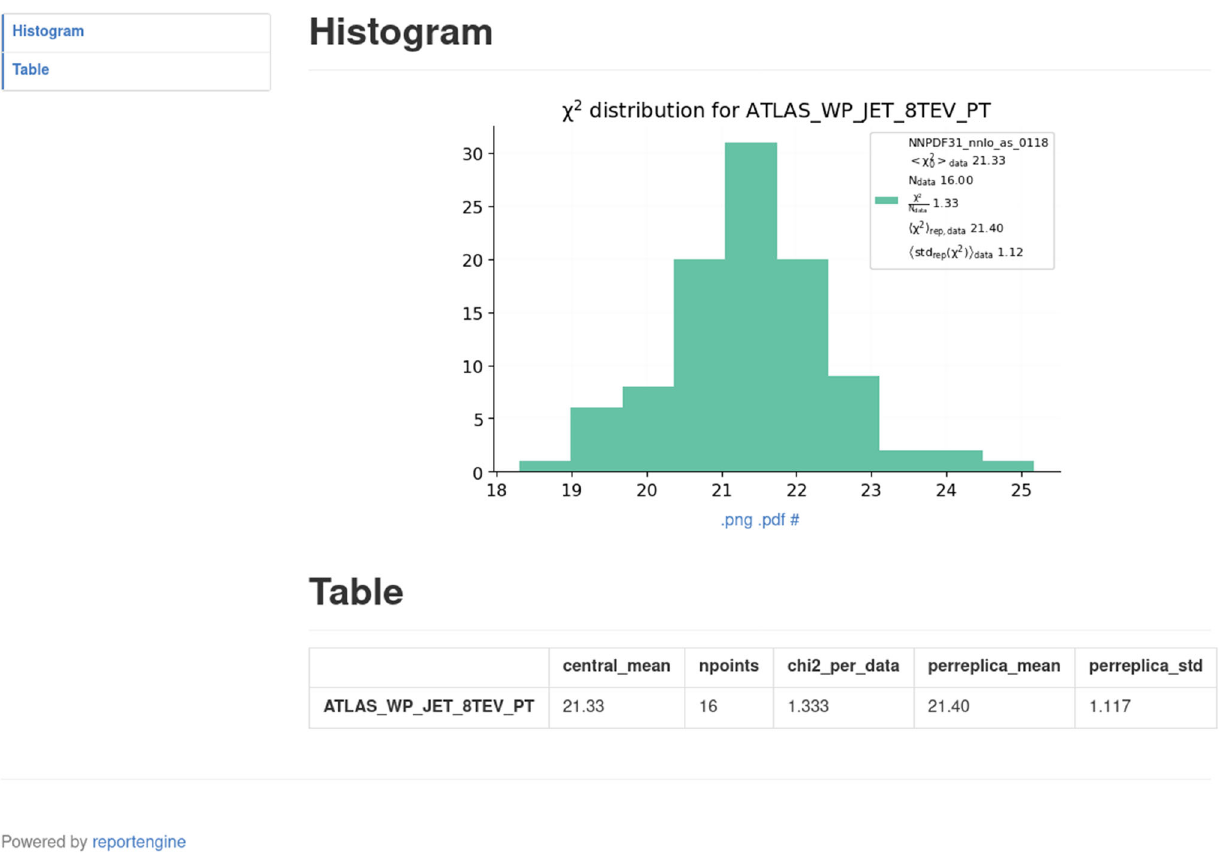
Fig. 4 The output of executing the runcard in Fig. 3 with validphys is an HTML report consistent of an histogram and the corresponding table indicating the distribution of χ 2 values over the N rep = 100 repli-